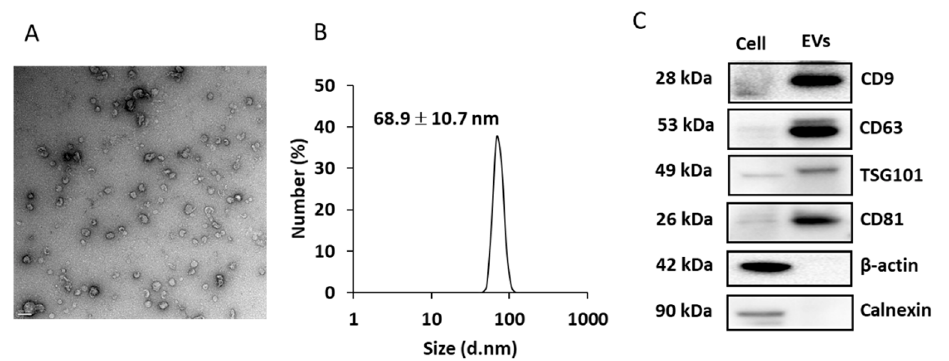
Figure 5. Characterization of the EVs isolated from culture media. ( A ) EVs imaged using transmission electron microscopy (TEM). Scale bar = 100 nm. ( B ) dynamic light scattering (DLS) analysis of the isolated EVs. ( C ) EV markers analyzed by Western blotting.